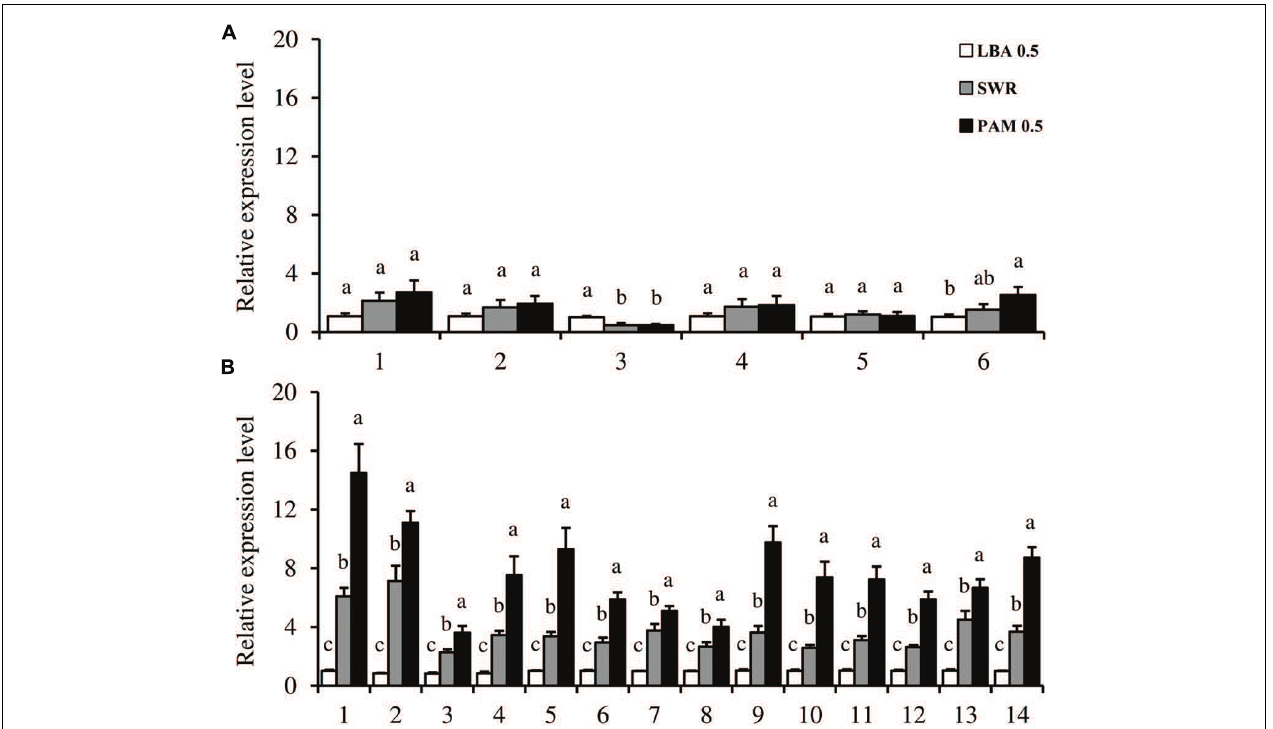
FIGURE 4 | Expression analysis of flagella and type IV pili-related genes in Lysobacter capsici AZ78. The expression of genes encoding flagellar (A) and type IV pili (B) regulatory and structural proteins was analyzed when L. capsici AZ78 was grown for 20 h on Luria Bertani Agar (LBA 0.5), Swarming Agar (SWR) and Pea Agar Medium (PAM 0.5); the media were amended with 0.5% Agar (w/v). Relative expression levels were calculated using recA as the constitutive gene for data normalization, and data were calibrated on L. capsici AZ78 growth on LBA 0.5 samples. An F -test revealed non-significant differences between experiments ( P values ranged from 0.08 to 0.96, for the genes tested), and data from the two experiments were pooled. Mean and standard error values were calculated as the pool of six replicates from two experiments. For each gene, different letters indicate significant differences according to Tukey’s test ( α = 0.05). (A) Flagellar genes: 1, flhB ; 2, fliR ; 3, flgE ; 4, flgI ; 5, fliH ; 6, fliA. (B) T4P genes: 1, pilA .1; 2, pilA .2; 3, pilZ ; 4, pilY 1; 5, pilB ; 6, clp ; 7, fimX ; 8, rpoN ; 9, pilM ; 10 pilG ; 11, pilI ; 12, pilL ; 13, pilJ ; 14, pilQ